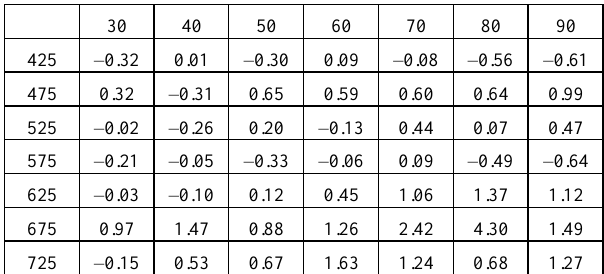
Table 3. The size of the error between the parameters measured on the test bench and the model of the neural network